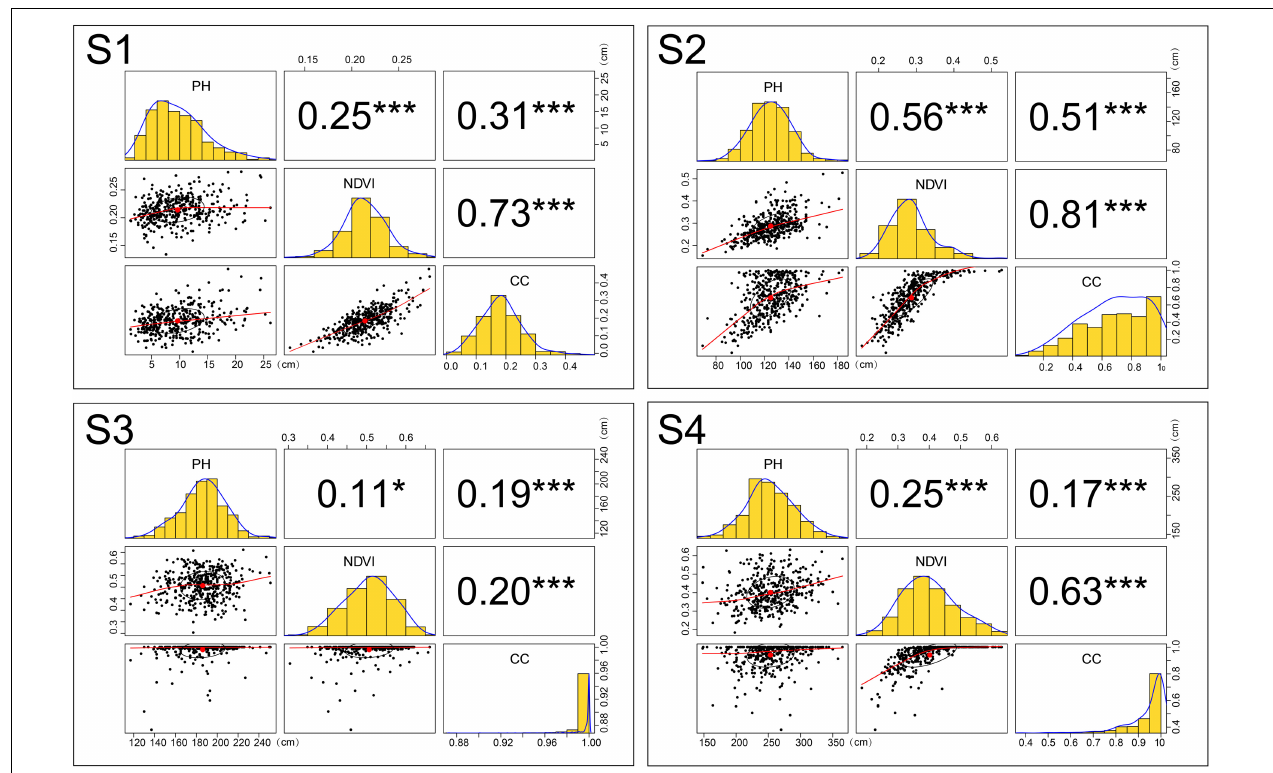
FIGURE 4 | Traits (CC, NDVI, and PH) relationships and distributions during four different growth stages. Numerical values represent Pearson’s correlation coefficients between two traits. Asterisks indicate significant correlations using a two-tailed t -test ( ∗∗∗ P < 0.001; ∗ P < 0.05). Black ellipses represent correlation ellipses around the mean to reflect the correlation. The red line in the scatter plot represents a linear or non-linear regression line. Histograms and density plots reflect the distributions of different traits. CC, canopy cover; NDVI, normalized difference vegetation index; PH, plant height.